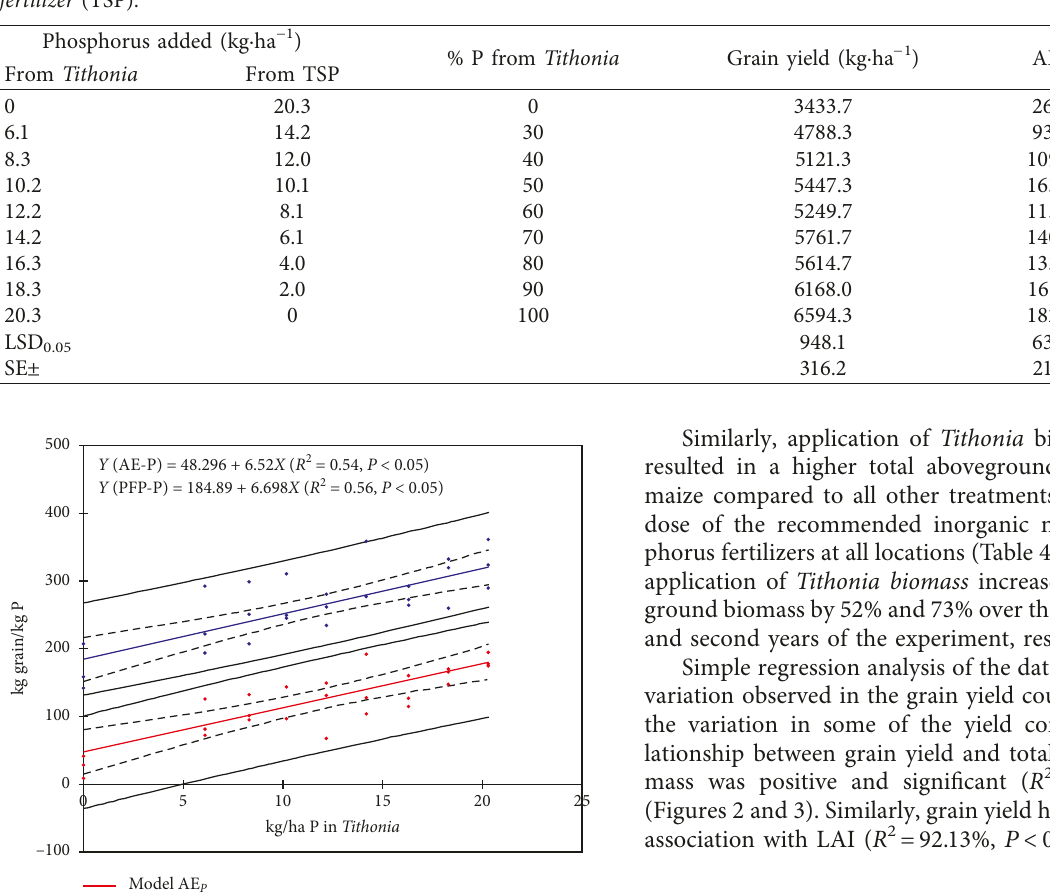
Table 3: Grain yield of maize and phosphorus use efficiency as affected by the combined application of Tithonia biomass and phosphorus fertilizer (TSP).